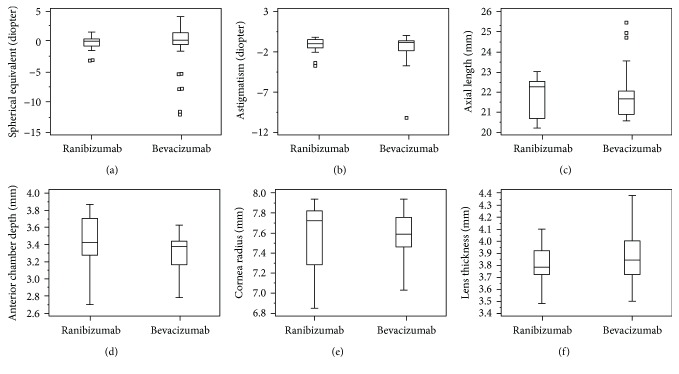
Box plots showing the distribution of refractive status and biometric comparisons at the corrected age of 3 years in children with ROP, treated with IVIs of either ranibizumab or bevacizumab. (a) Spherical equivalent; (b) astigmatism; (c) axial length; (d) anterior chamber depth; (e) cornea radius; (f) lens thickness. There was a significant difference only in anterior chamber depth (p = 0.01) between the eyes in the two groups but the differences were not seen in other parameters.